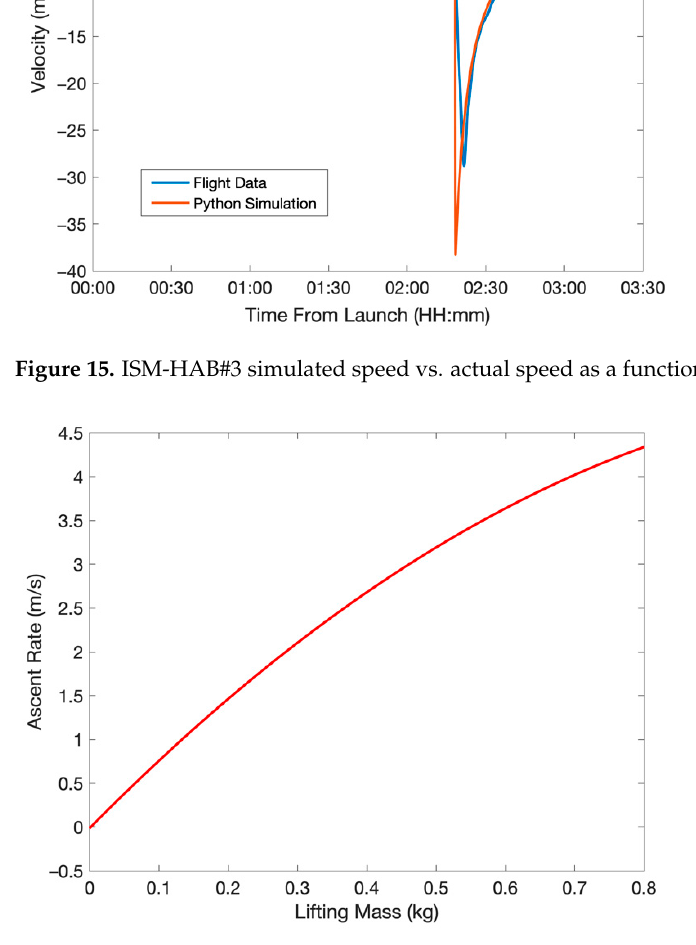
Figure 16. Ascent rate as a function of lifting mass.